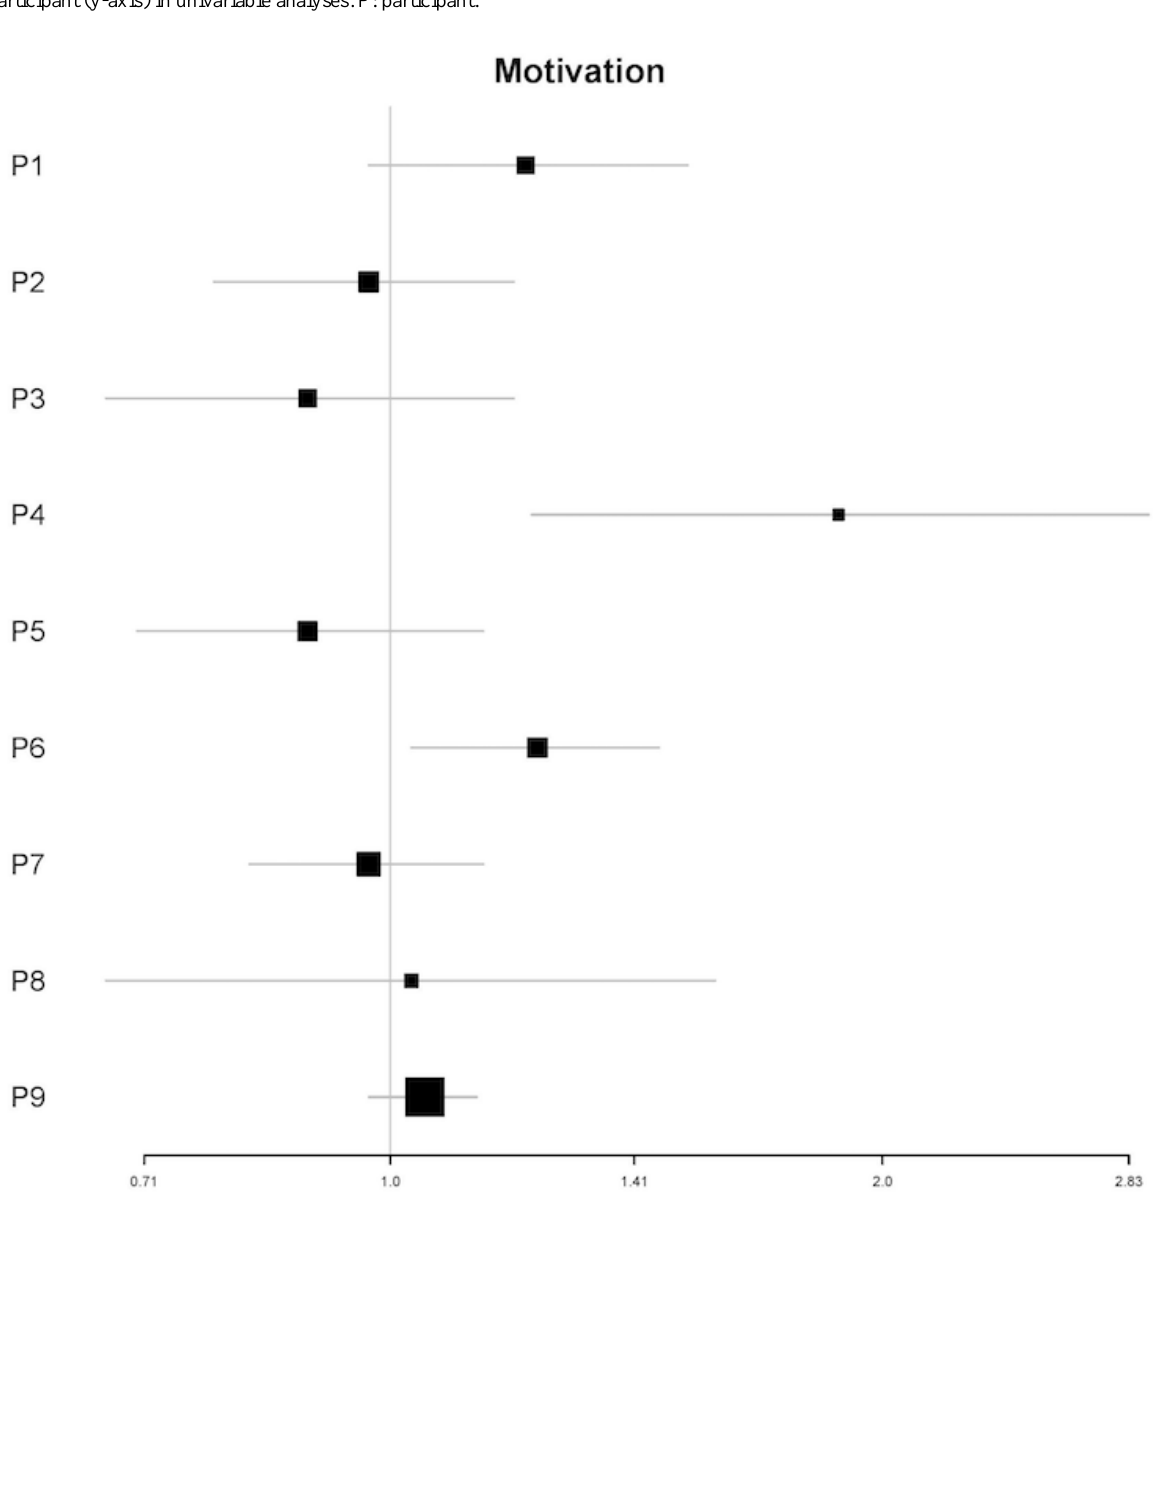
Figure 3. Plot of incidence rate ratios and 95% CIs (x-axis) for the association of motivation to reduce alcohol and the frequency of engagement for each participant (y-axis) in univariable analyses. P: